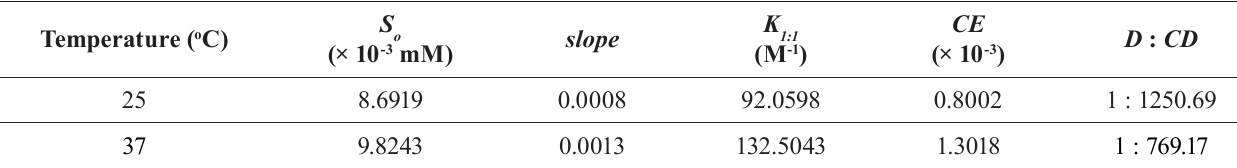
TABLE III - The saturation concentrations of CPHC in pure water, CPHC : 2-HP-β-CD s lopes, apparent stability constants, the complexation efficiency of CPHC : 2-HP-β-CD complexes and the CPHC: 2-HP-β-CD ratio, at 25 °C and 37 °C ± 0.1 °C